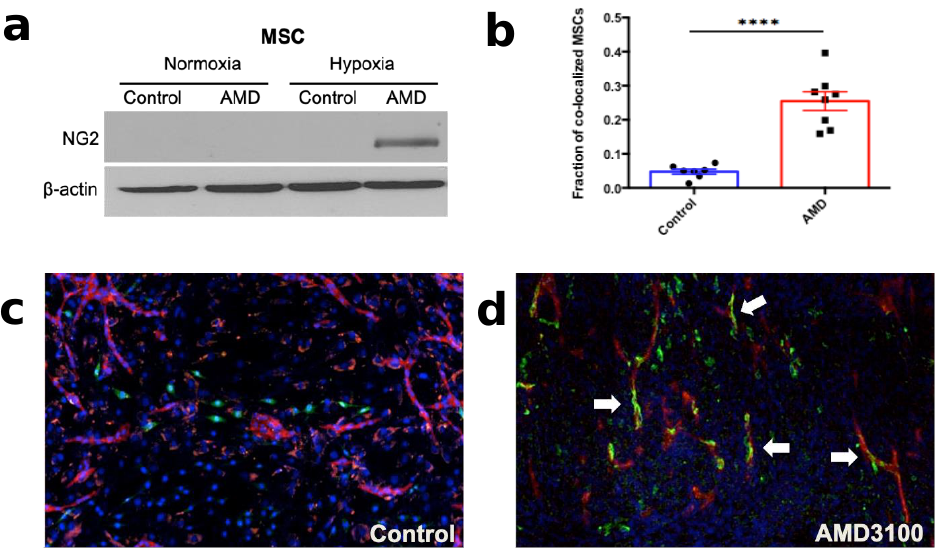
Figure 6. Effects of CXCR4 inhibition with AMD3100 on phenotype of MSCs and their vessel stabilizing action in vitro. ( a ) Increased expression of pericyte marker NG2 following incubation of MSCs under hypoxic (1% O 2 ) but not air conditions. ( b – d ) Increased co-localization of MSCs with endothelial cells in HUVEC-SMC co-culture after incubation with AMD3100 ( b ). Representative fluorescence microscopy of co-cultures in the control ( c ) and AMD-treated ( d ) groups. Arrows show the perivascular MSCs. In blue, DAPI counterstaining; in red, CD31; and in green, NG2. **** p <